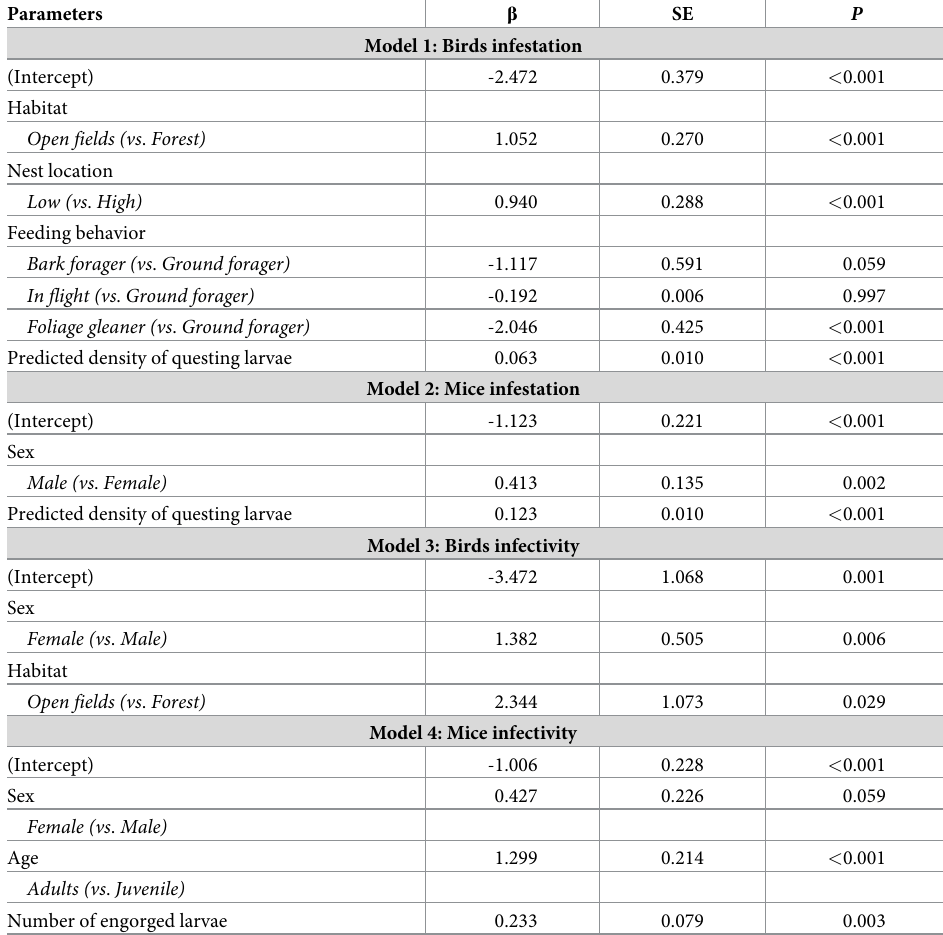
Table 4. Fixed effect parameter estimates for the best generalized mixed models of larval abundance on hosts (models 1 and 2) and the probability of transmission of B . burgdorferi from host to feeding larva (models 3 and 4) in 2017 and 2018 �